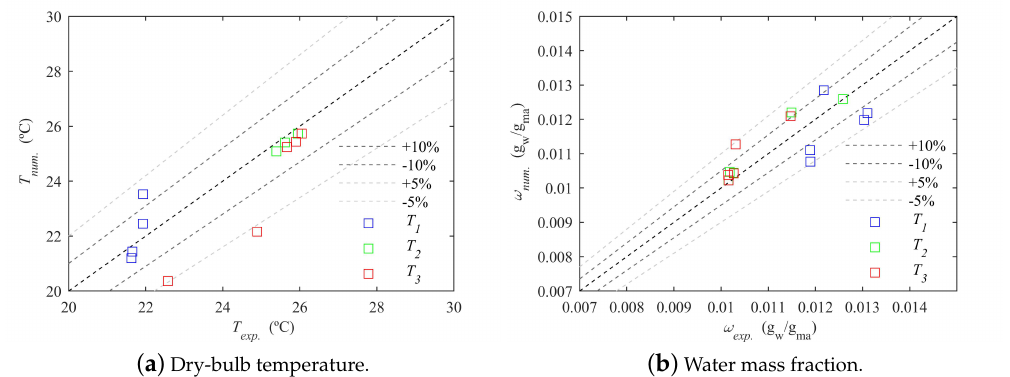
Figure 8. Comparison of calculated (CFD) and measured for the experimental tests displayed in Table